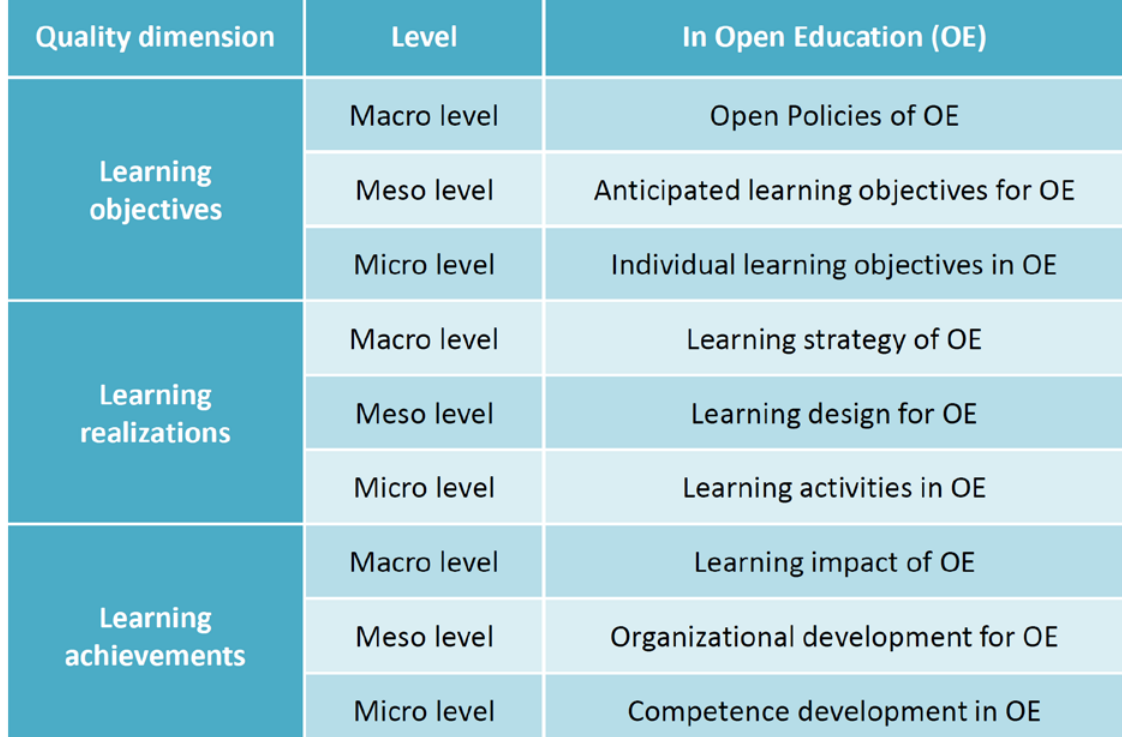
Quality Dimensions in Open Education at the Three